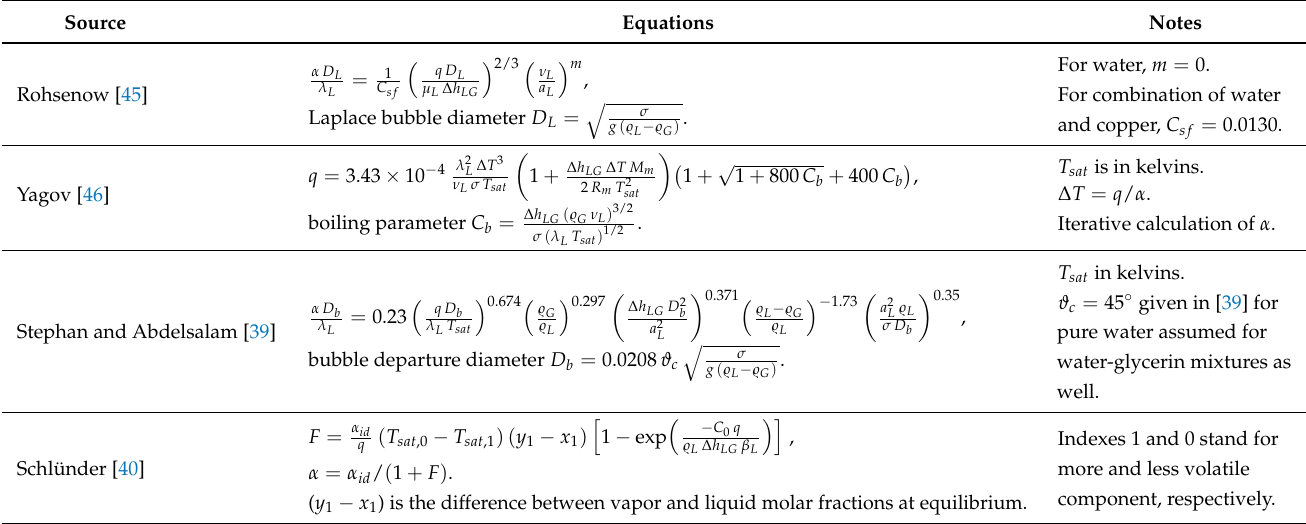
Figure 4. Validation of results and repeatability for water and water–glycerin mixture. Table 6. Correlations for calculation of HTC which were compared with the experimental